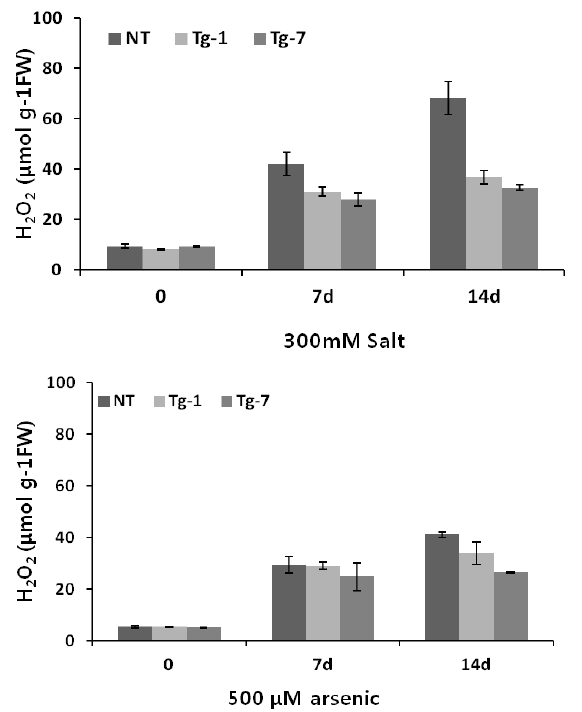
Figure 5. Effects of salt and arsenic stresses on H 2 O 2 accumulation in leaves of control (NT) and transgenic (Tg-1, Tg-7) plants. Data represent the mean and standard deviation (SD) of 3 independent